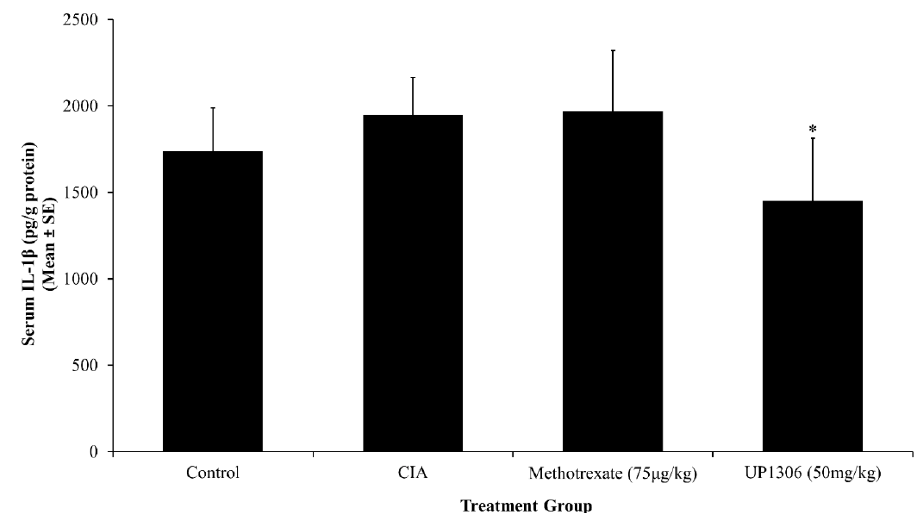
Figure 5. Effect of UP1306 on rat serum interleukin-1 β (IL-1 β ) level normalized with protein in CIA model treated for three weeks post immunization. Data are Mean ± SE. * p ≤ 0.05 vs. vehicle treated CIA.